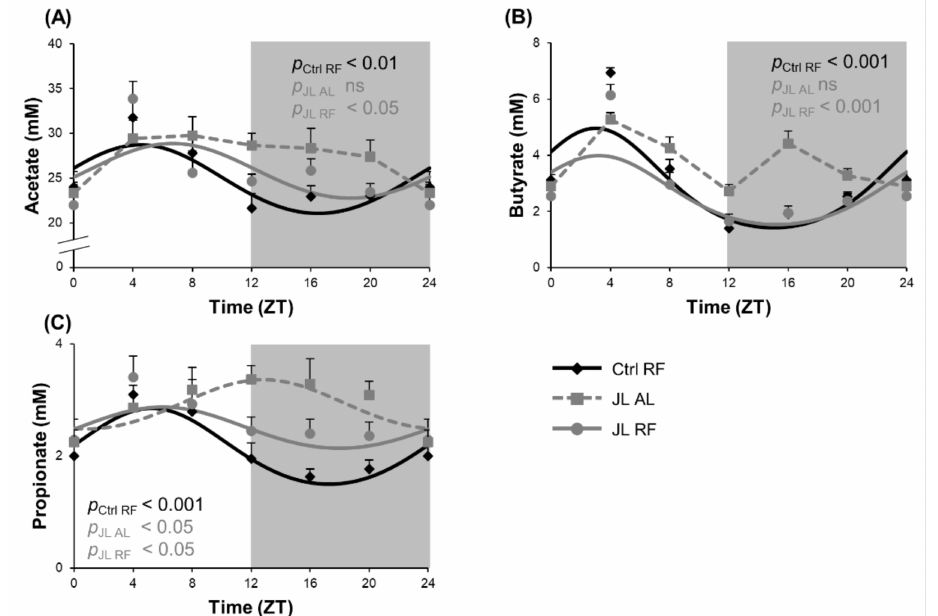
Figure 6. Effect of time restricted feeding on diurnal fluctuations in fecal SCFA concentrations. Fecal ( A ) acetate, ( B ) butyrate and ( C ) propionate concentrations in the distal colon of control mice fed a TRF diet (Ctrl RF), jetlagged mice fed ad libitum (JL AL) and jetlagged mice fed a TRF diet (JL RF) ( n = 8mice per time point per group). The fitted cosine curve determined by cosinor analysis (period = 24 h) are shown. The dark phase is shaded grey. Statistics: Non-linear regression (Proc NLIN). ns = not significant. p -values refer to probability values for the best fitting cosine